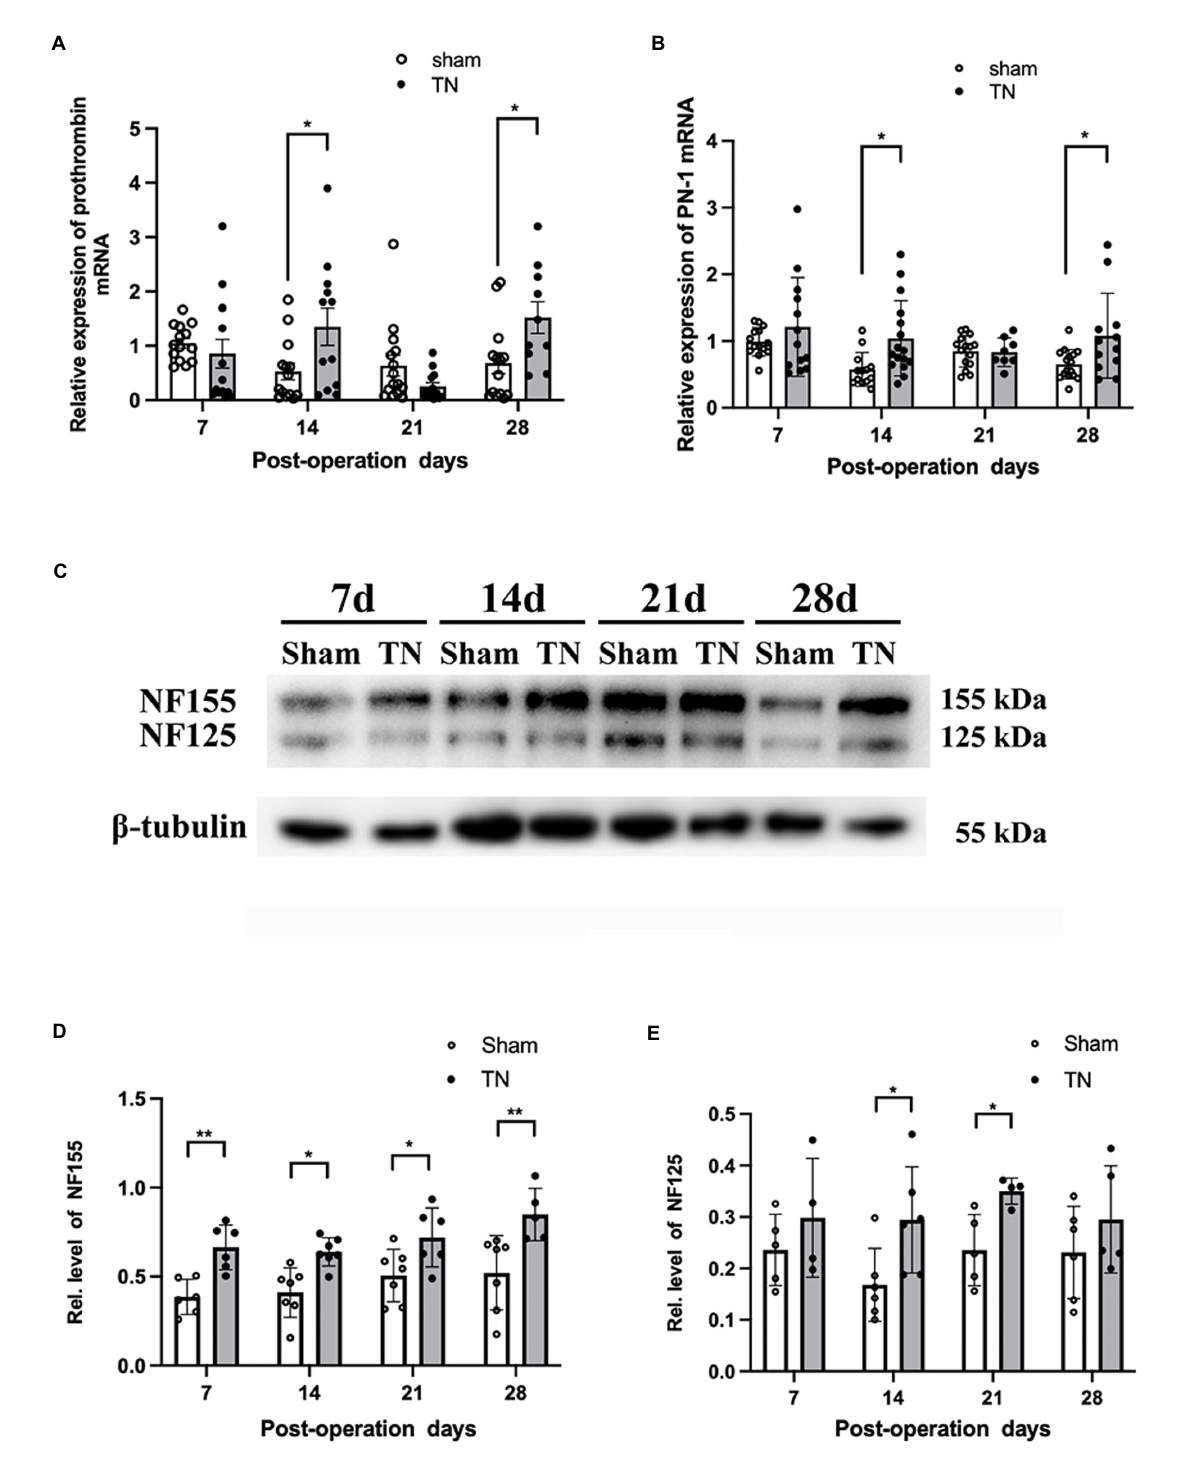
FIGURE 6 Chronic compression injury changed the expression of prothrombin, PN-1, NF155, and NF125 in the TREZ. (A) Transcription levels of prothrombin in the TREZ were significantly increased in the TN group on PODs 14 and 28 compared with the sham group. (B) Transcription levels of PN-1 in the TN group were significantly upregulated on PODs 14 and 28. (C) Two protein bands representing NF155 and NF125 were detected in the immunoblotting assay. (D) Compared with the sham group, the expression of NF155 in the TREZ of the TN group increased significantly from PODs 7 to 28. (E) The expression of NF125 was higher in the TN group on PODs 14 and 21 than in the sham group. Data are presented as the mean ± SD ( n = 4–7/group). All comparisons were analyzed using two-way ANOVA and Sidak’s multiple comparisons test. * p < 0.05 , ** p < 0.01 , *** p < 0.001 , and **** p < 0.0001